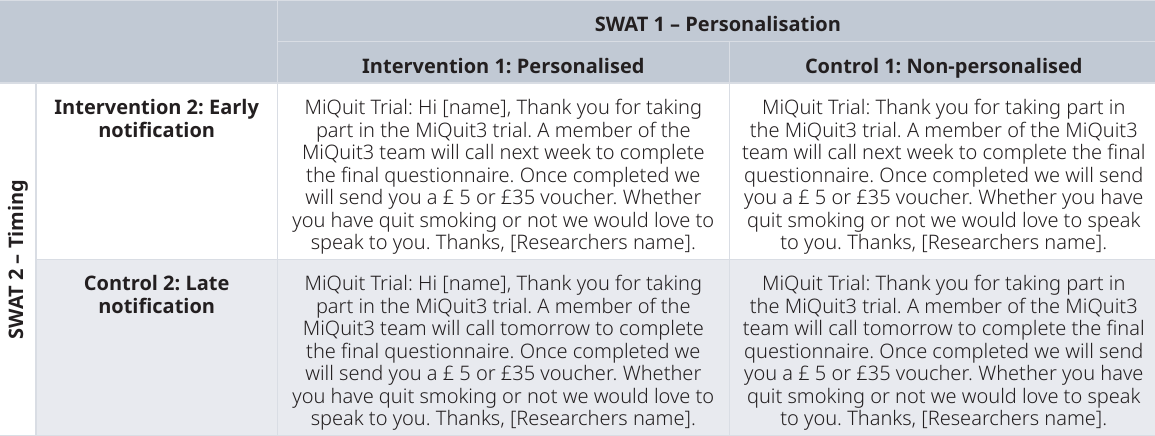
Table 1. Details of the SWAT interventions and